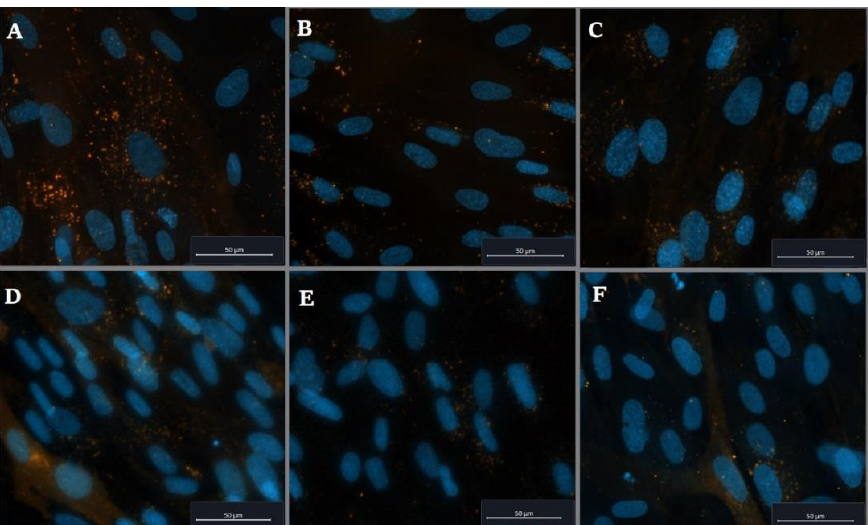
Figure 8. Composite fluorescence micrographs of CRL2429 fibroblasts after uptake of pure DiI ( A —without inhibitors; B —in the presence of dynasore; C —in the presence of wortmannin) and DiI loaded nanocarriers ( D —without inhibitors; E —in the presence of dynasore; F —in the presence of wortmannin). Cell nuclei are shown in blue as nucleic dye Hoechst 33258 was used. Orange color corresponds to the fluorescence at the DiI emission wavelength.